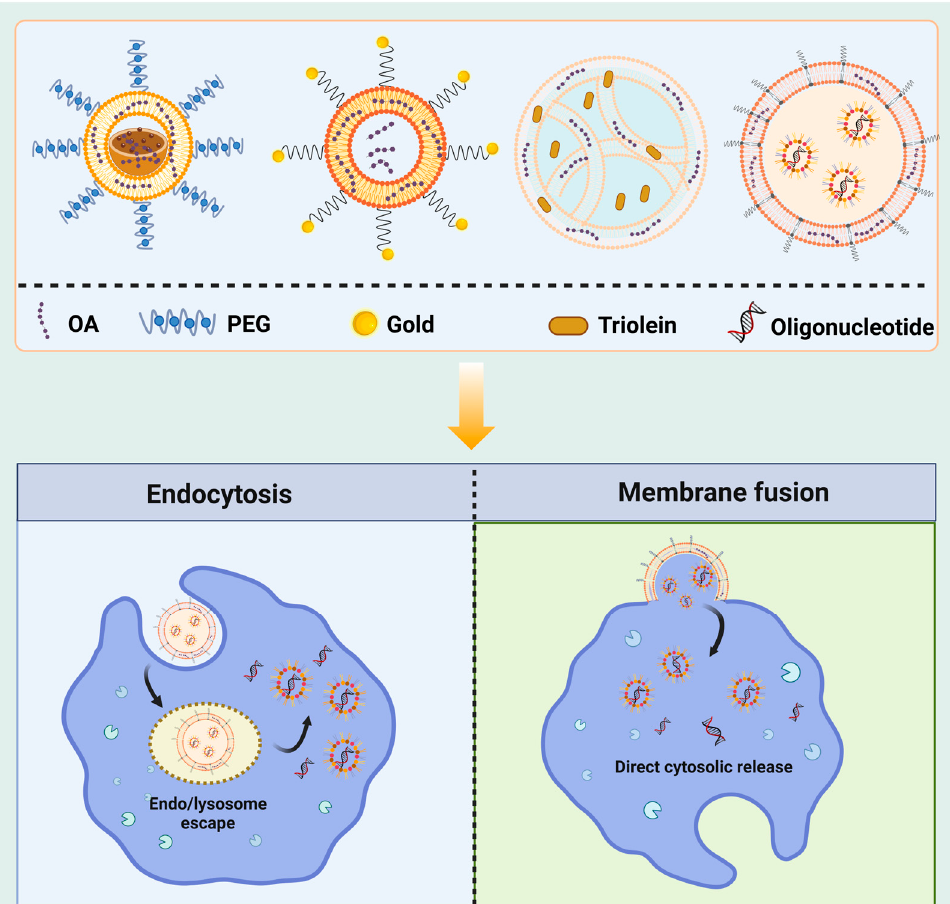
Figure 4. Common modifications and intracellular delivery modes of nanoliposomes.